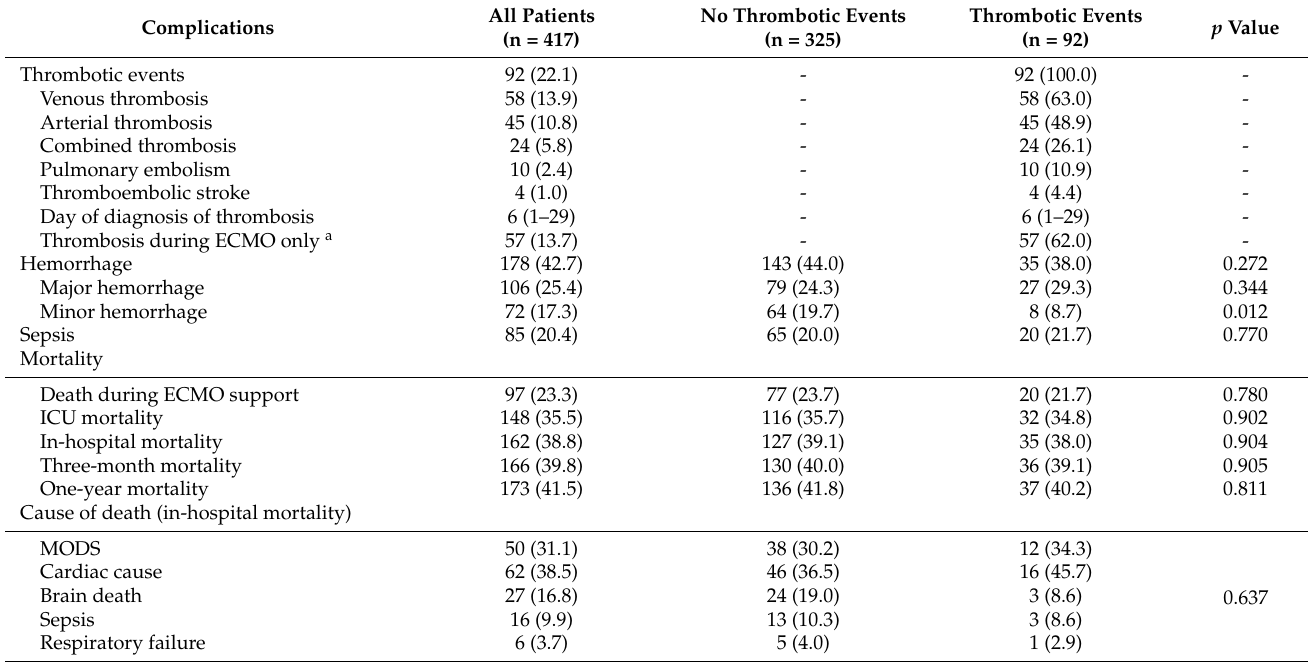
Table 3. Adverse events and mortality during ECMO support (n =